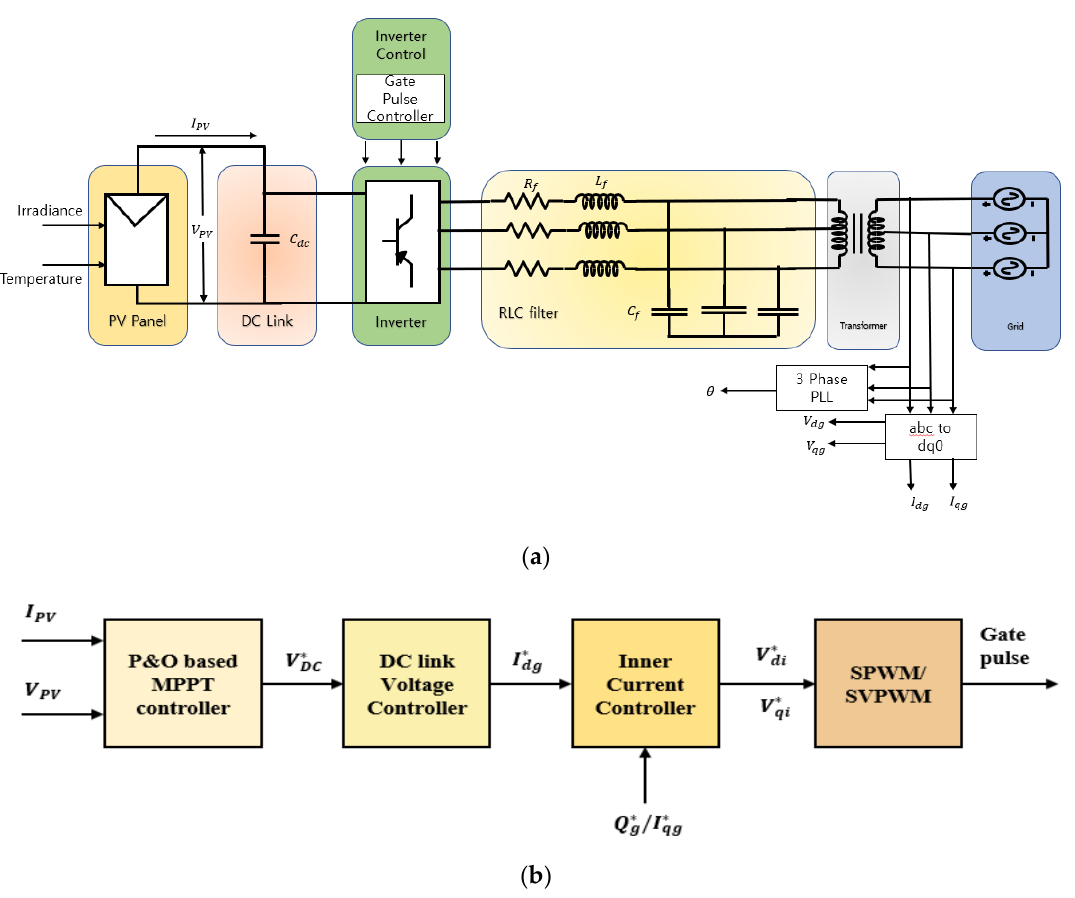
Figure 1. Single-stage three-phase grid-connected photovoltaic (PV) system: ( a ) overall system; ( b ) inside inverter control block.